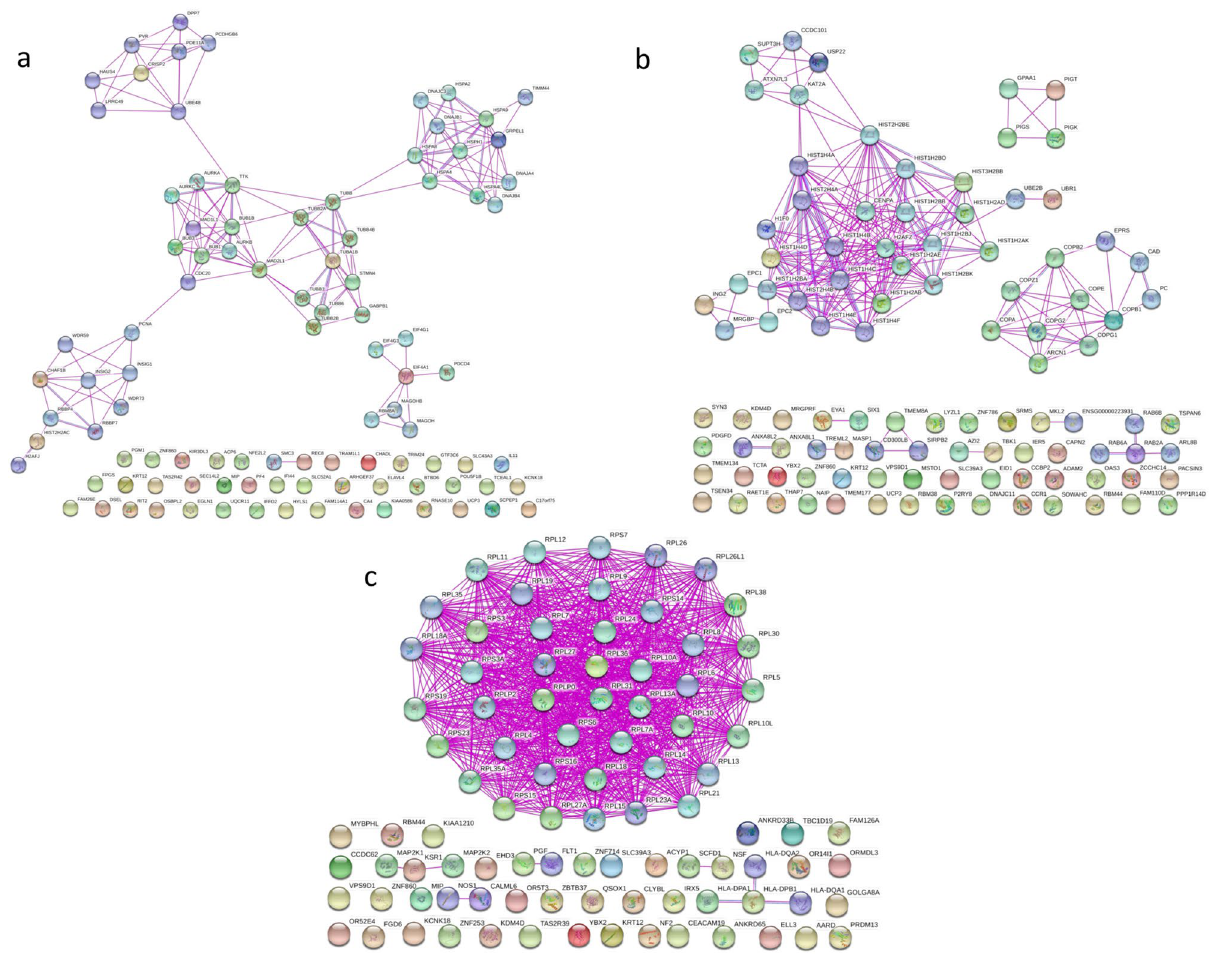
Figure 6. Protein–protein interaction network (PPI) analysis for the CvsE ( a ), CvsH ( b ), and CvsEvsH ( c ) DEG lists. Nodes represent proteins and edges represent protein–protein interactions. The main interaction map consists of seed proteins protein (encoded by the DEGs) and their direct interaction partners (first degree interactors identified by the String database). The DEGs without any connection are listed at the bottom of the figure (More detailed version is available in Supplementary as Figs. S7–S9,